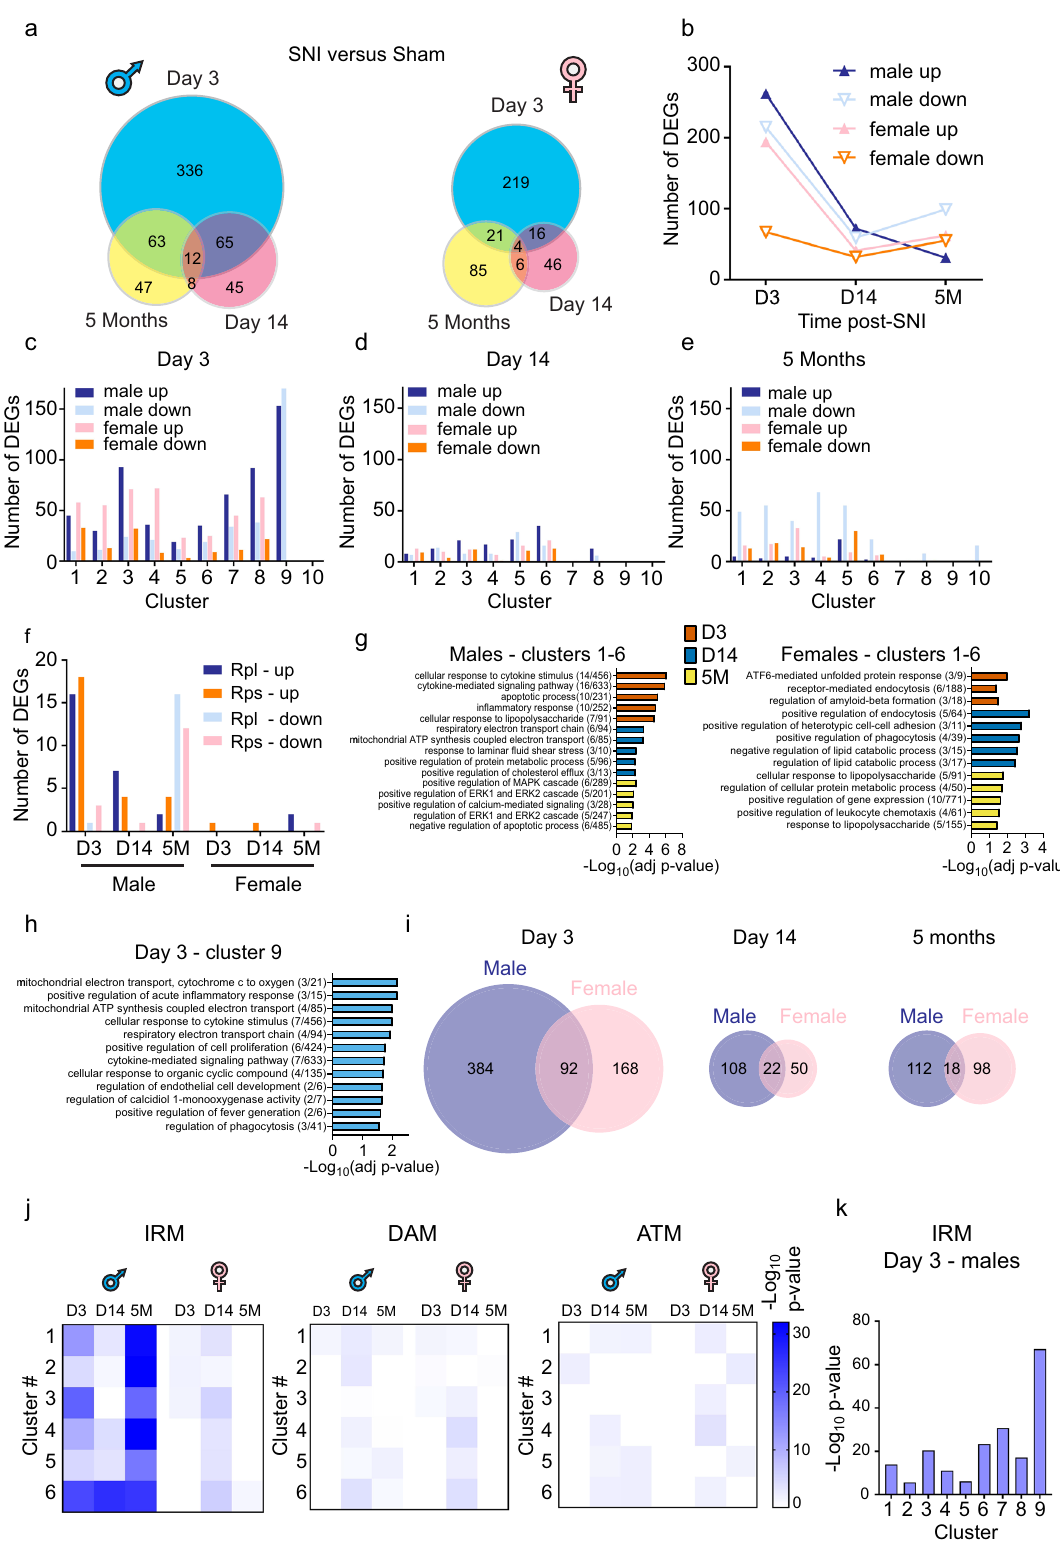
and 6; females: top upregulated gene in clusters 1 – 6) and 5 months (top upregulated gene in clusters 1 – 6 in males and females) (Fig. 4a – c). ApoE protein in the spinal cord dorsal horn is present in neurons, astrocytes, and microglia (Fig. 4d). As expected, ApoE immunoreactivity in microglia was found in